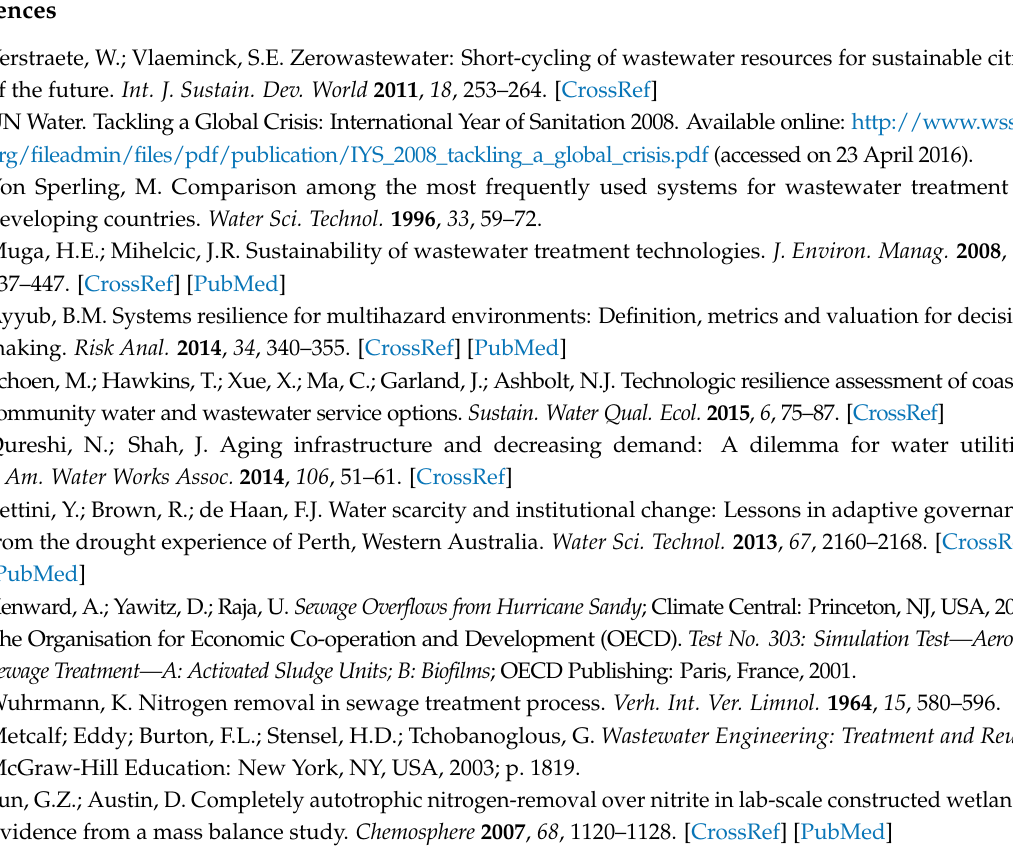
Figure S1: Predicted BOD effluent concentrations of the three systems during the peak scenario, Figure S2: Predicted COD effluent concentrations of the three systems during the peak scenario, Figure S3: Predicted TN effluent concentrations of the three systems during the peak scenario, Figure S4: Predicted TP effluent concentrations of the three systems during the peak scenario, S5: Outcomes of power analysis